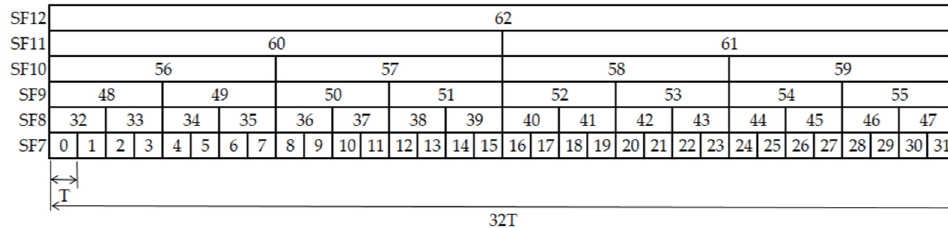
Figure 3. Ideal frame structure in TSSFH approach.